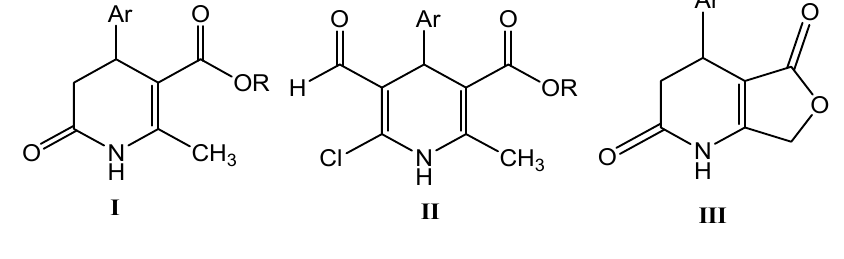
Figure 1. Chemical structures of alkyl 4-arylsubstituted-2-methyl-6-oxo-1,4,5,6- tetrahydro-3-pyridinecarboxylates I , alkyl 4-arylsubstituted-6-chloro-5-formyl-2-methyl- 1,4-dihydropyridine-3-carboxylates II and 4-arylsubstituted-4,7-dihydrofuro[3,4- b ]pyridine- 2,5(1H,3H)-diones III .